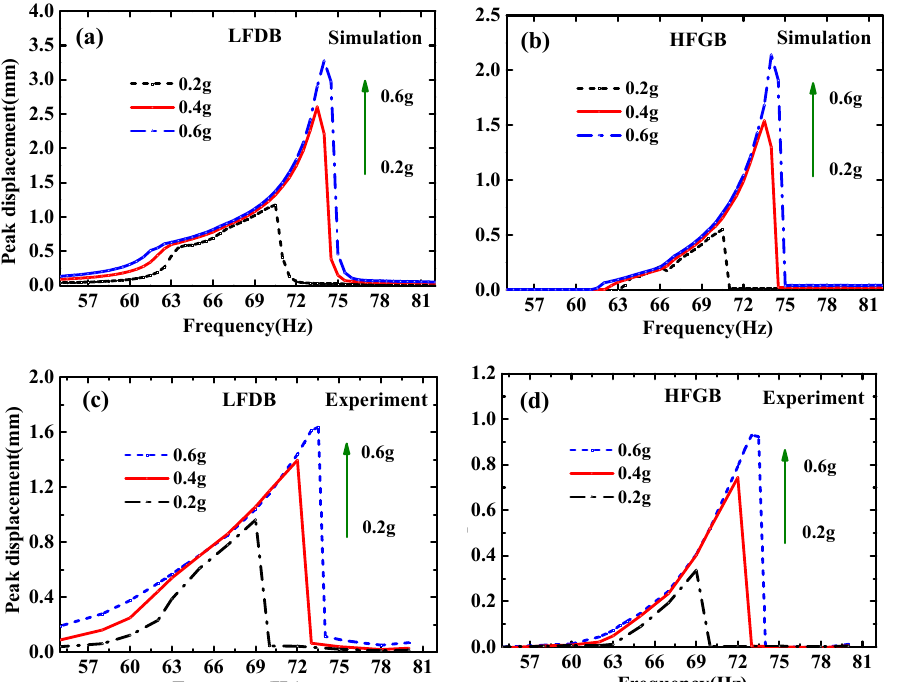
Figure 7. Frequency responses of the peak displacement of LFDB and HFGB for various accelerations under the condition of Δ x = 0.5 mm and k 0 = 1150 N/m: ( a ) simulation frequency responses of LFDB; ( b ) simulation frequency responses of HFGB; ( c ) experimental frequency responses of LFDB; ( d ) experimental frequency responses of HFGB.